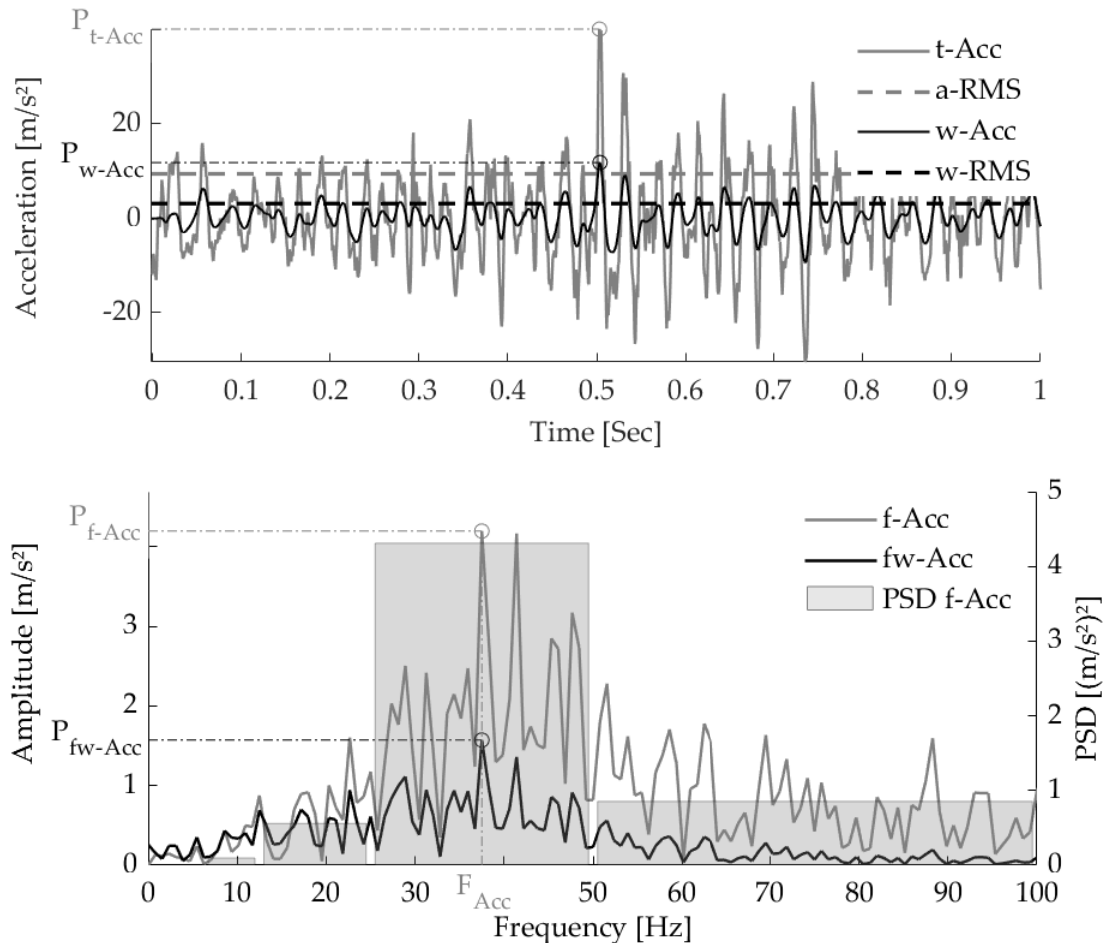
Figure 1. Representation of an acceleration signal in both time and frequency domains and the different parameters extracted in the articles were t-Acc, w-Acc are the acceleration and frequencies pondered signal in the time domain, f-Acc, fw-Acc are the acceleration and frequencies pondered spectrum and P t-Acc , P w-Acc , P f-Acc , P fw-Acc are peak level of each signal, respectively. A-RMS and w-RMS are the mean level of t-Acc and w-Acc, respectively. PSD F Acc is the power spectral density of the f-Acc.